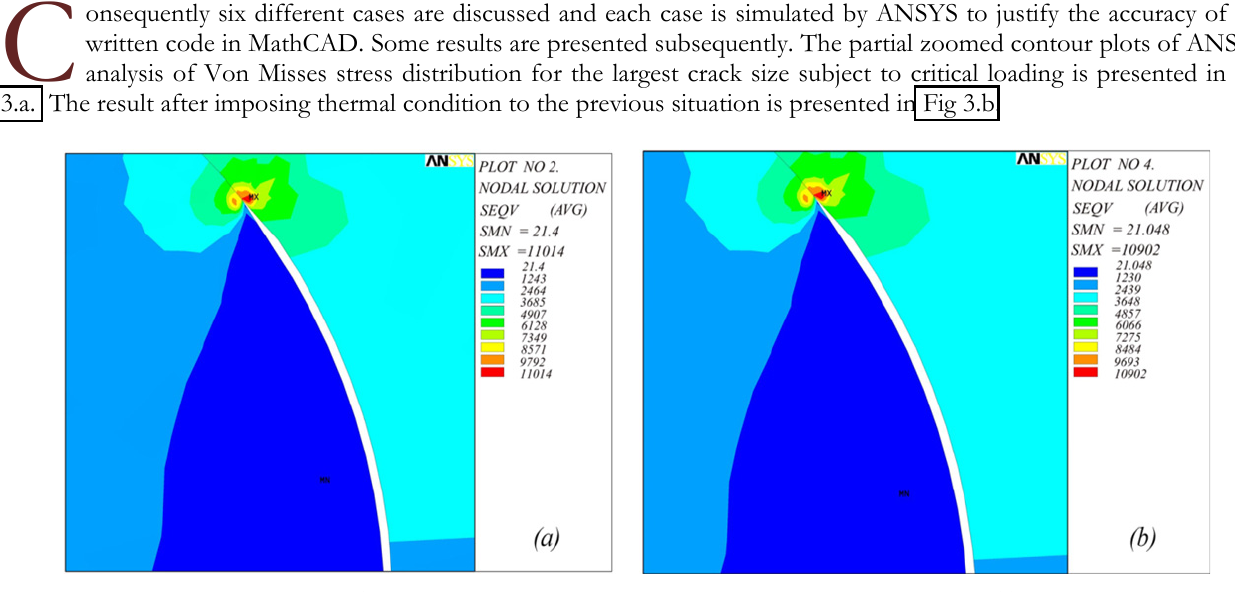
Figure 3: Zoomed contour plots for maximum crack length (critical length), simulated by ANSYS, (a) Von Misses stress distribution subject to critical loading, (b)Von Misses stress distribution subject to critical loading and thermal condition.